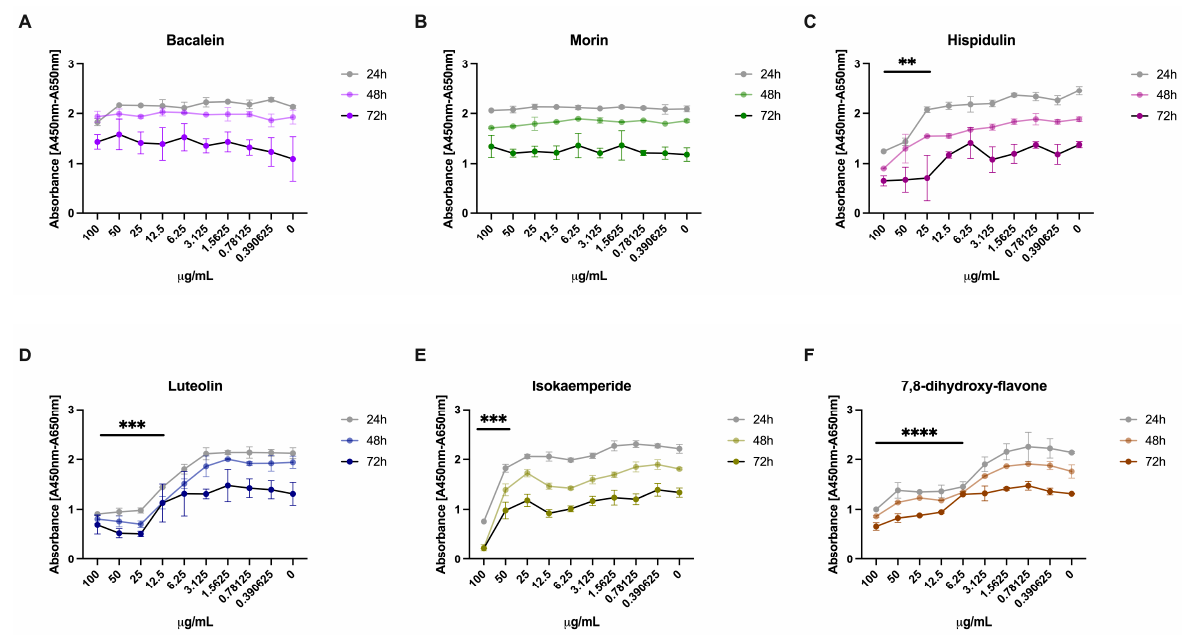
Figure 1. Cell viability analysis. Different concentrations (100-0.4 µg/mL) of the selected